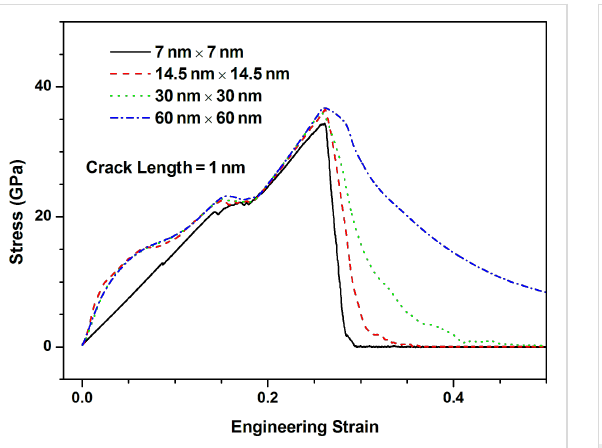
Figure 10: The stress–strain curves along armchair direction of MoS 2 sheet with the crack of 1 nm length for different crack locations. With the increase of crack length, the fracture strength of pre- cracked MoS 2 sheet reduces almost bi-linearly as shown in Figure 12. In order to better understand the effect of crack length on the fracture behaviors of pre-cracked MoS 2 sheet, two continuum fracture mechanics models, i.e., Inglis' model [25] and Griffith's model [26] as expressed by Equation 3 and Equa- tion 4 without finite size effect, are used to estimate the fracture stresses of pre-cracked MoS 2 sheets with different crack